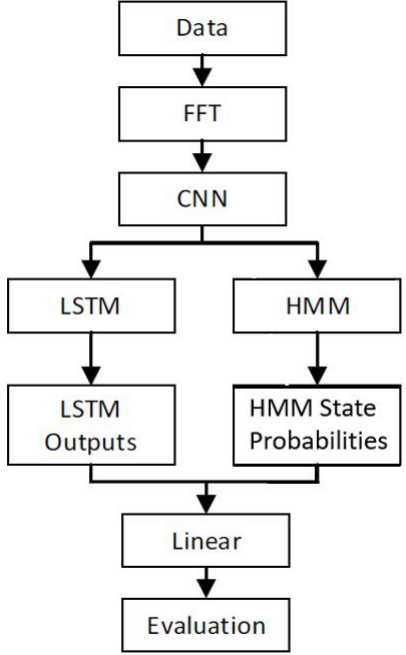
Figure 14. Proposed model for remaining life engine prediction